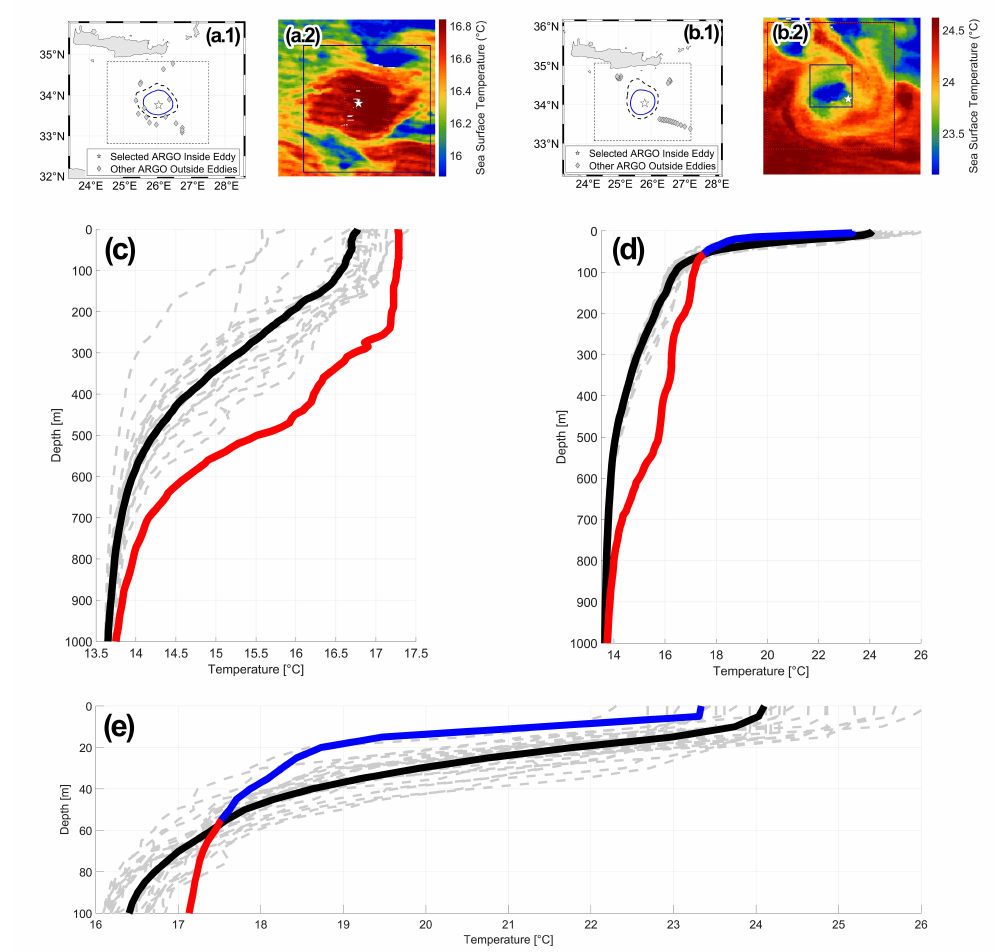
Figure 9. Seasonal evolution of the vertical structure of the Ierapetra eddy. Panels ( a , c ) correspond to a Warm Core SST observation of the eddy on 26/02/2017. Panels ( b – e ) correspond to a Cold Core SST observation on 26/07/2017. Maps ( a.1 , a.2 ) show the maximum velocity contour and outermost contour of the eddy, the eddy-sampling ARGO profile with a star and the outside-eddy profiles with diamonds, which are retained in a region outlined by the dashed rectangle. Patches ( b.1 , b.2 ) show the SST anomaly of the eddy along with the location of the eddy-sampling profile, which is plotted with a star. Vertical plots ( c – e ) show the outside-eddy profiles plotted with dashed gray lines and their mean outside-eddy profile with a thick black line. The eddy-sampling profile is plotted with a thick red (blue) line when it is warmer (colder) than the mean outside-eddy profile. Profile ( c ) shows the winter regular surface anomaly, with a warm structure, profile ( d ) shows the summer inverse surface anomaly with a cold surface and a warm subsurface structure, while panel ( e ) zooms into the 100 first meters of ( d ) to portray the SST